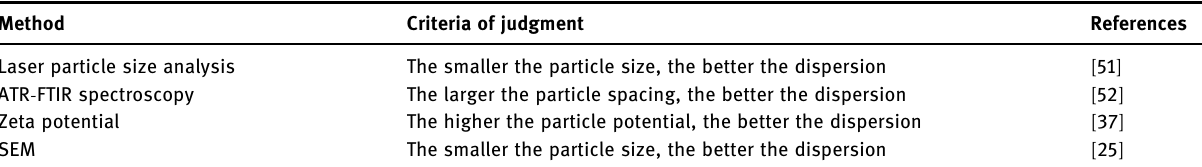
Table 2: Characterization of dispersion of nanomaterials in suspensions